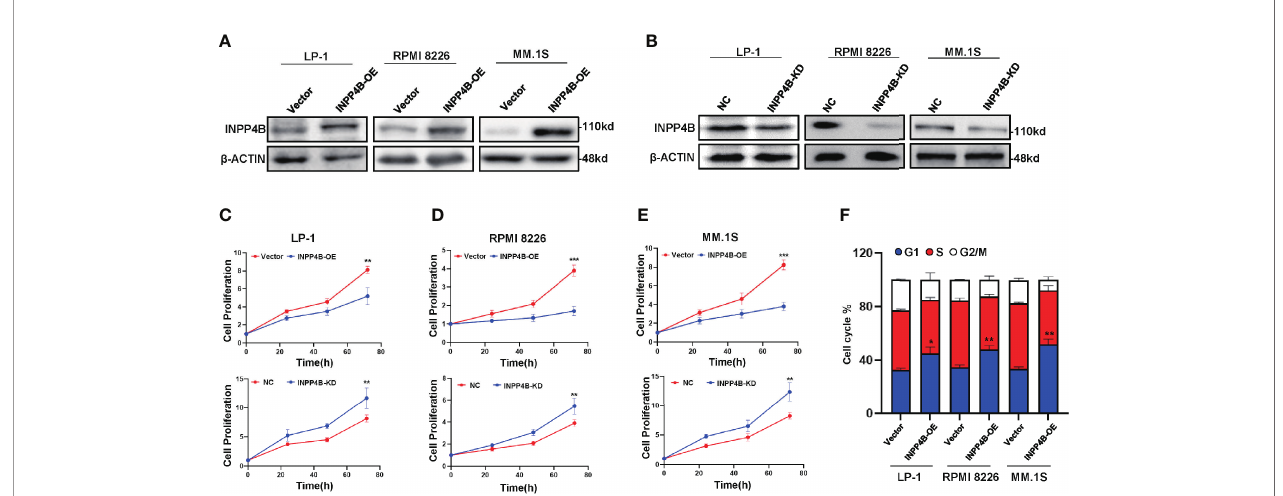
FIGURE 3 | INPP4B overexpression inhibits the proliferation of MM cells in vitro . (A) Western blot shows the overexpression of INPP4B in LP-1, RPMI8226, and MM.1S cells infected with lentivirus carrying INPP4B. (B) Western blot assay reveals the ef fi ciency of INPP4B knockdown by lentiviral-carrying infection of shRNA. The CCK8 assay to detect the effect of INPP4B knockdown (KD) and overexpression (OE) on cells proliferation in (C) LP-1, (D) RPMI8226, and (E) MM.1S cells. NC, non-target control. (F) Cell cycle assay shows that overexpression of INPP4B arrested MM cells at G0/G1 phase. Data were plotted as mean ± SD from three independent experiments (* p < 0.05, ** p < 0.01, *** p < 0.001 vs. the